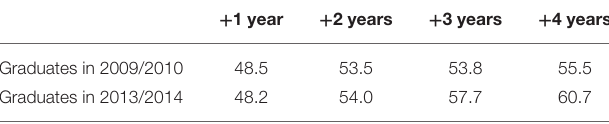
TABLE 8 | Rate of graduates employed in their professional category in the following 4 years to graduation. + 1 year + 2 years + 3 years + 4 years Graduates in 2009/2010 48.5 53.5 53.8 55.5 Graduates in 2013/2014 48.2